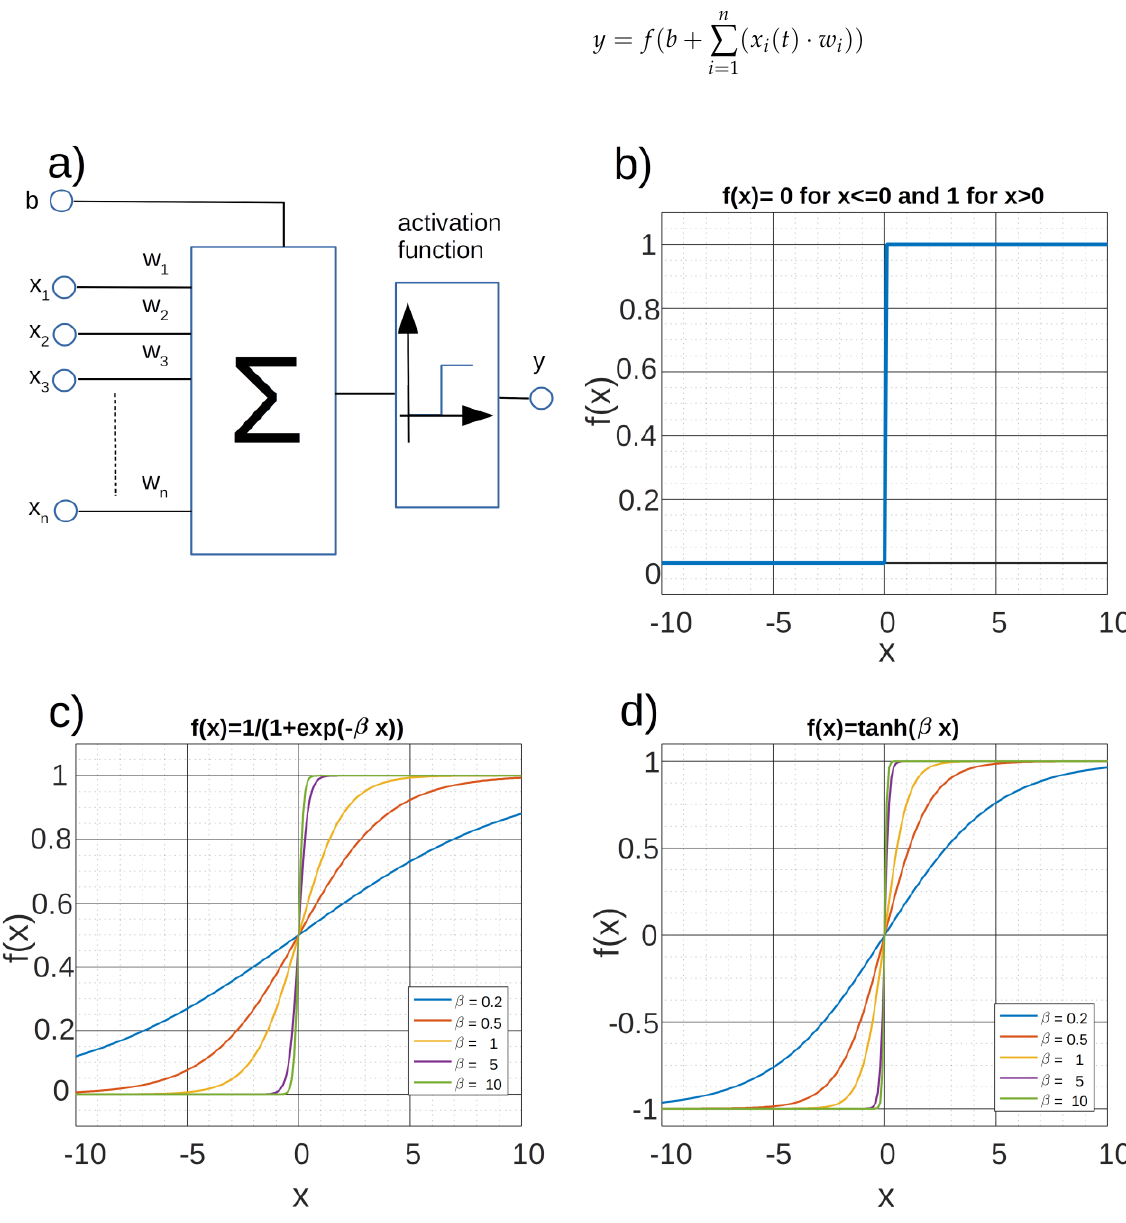
Figure 2. ( a ) Basic scheme of a single neuron (perceptron basic diagram); ( b ) the course of the function response taking only two values–[0, 1], the function f(x) is called the Heaviside step function; ( c ) graph of the unipolar sigmoidal function response of the neuron–the values accepted by the activation function are in the range <0.1>, the function of f(x) is known as “logistic growth function’ and β represents the “logic growth rate”; ( d ) graph of the neuron’s bipolar response–the values of the activation function are in the range < − 1.1>. In ( b , c ), the slope of the curve depends on the parameter B (beta), increasing the value of this parameter brings the graph closer to a step function. Both of these functions are continuous functions.